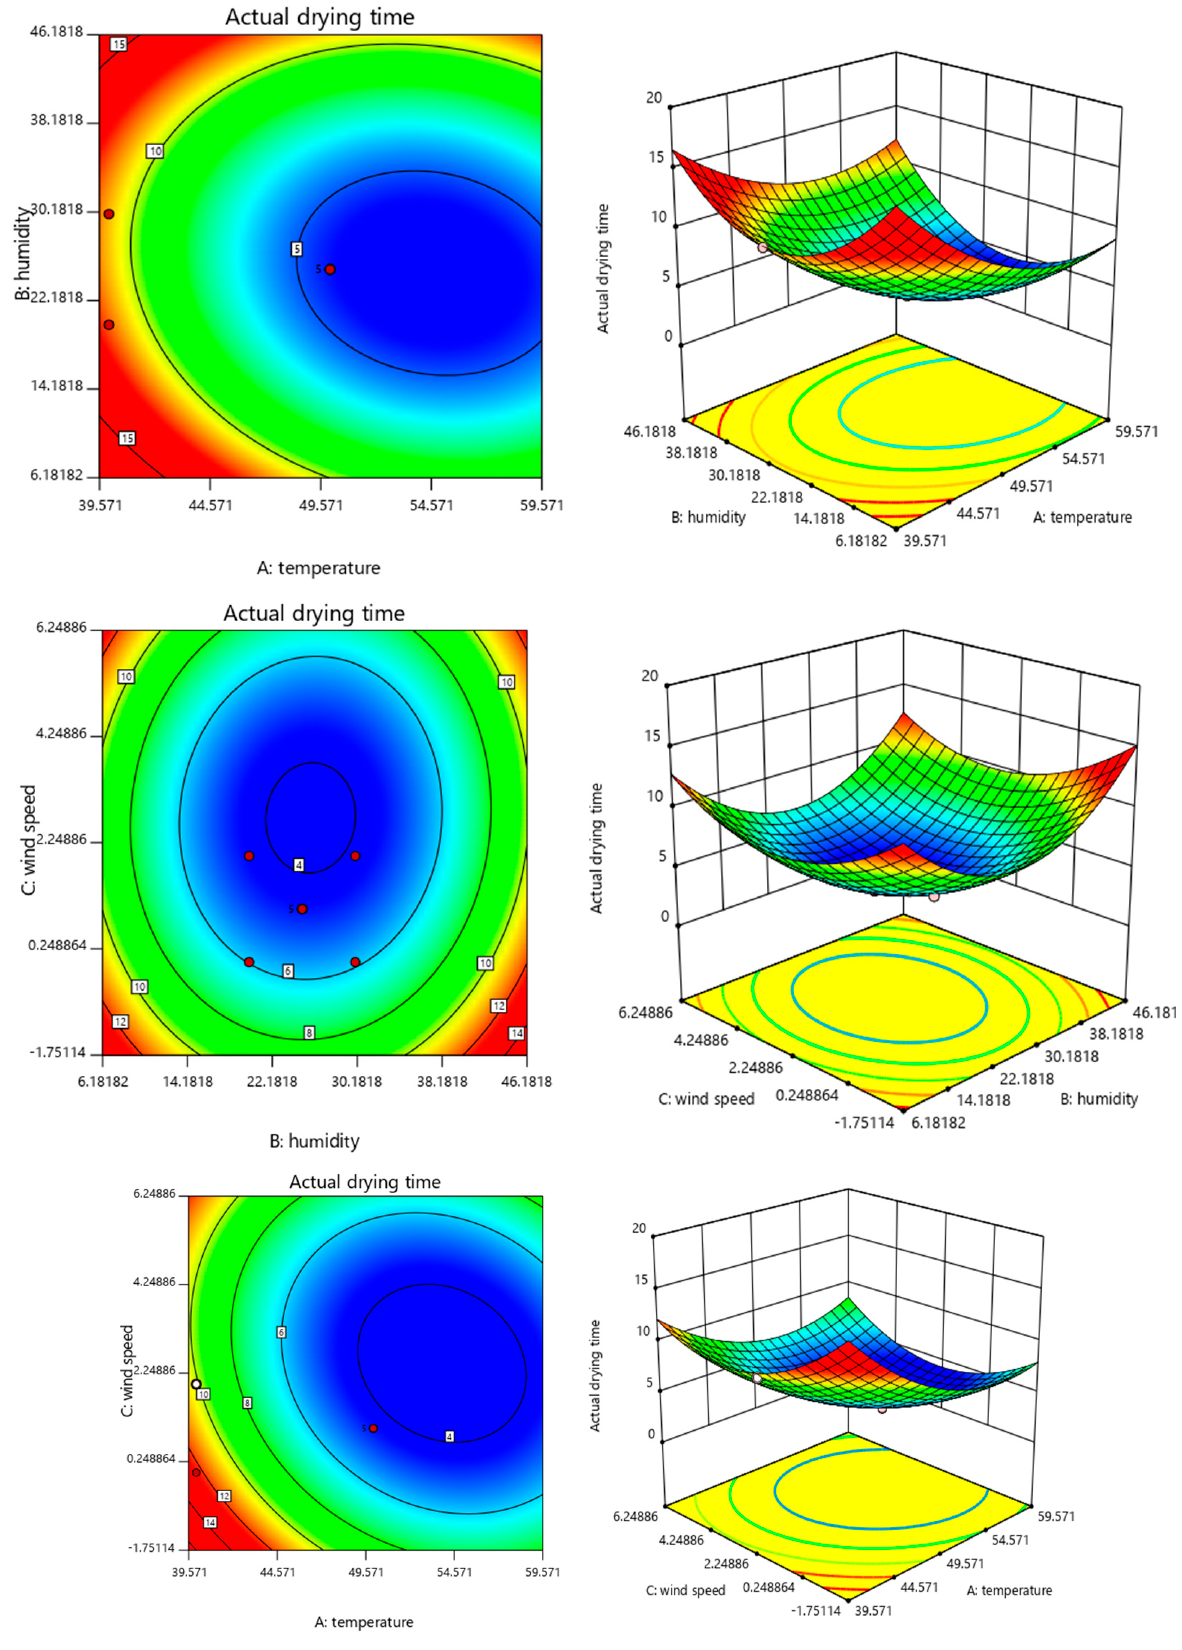
Figure 6. The response surface and contour of temperature, humidity and wind speed for the solid drying time. (Left is the response surface, right is the contour map).